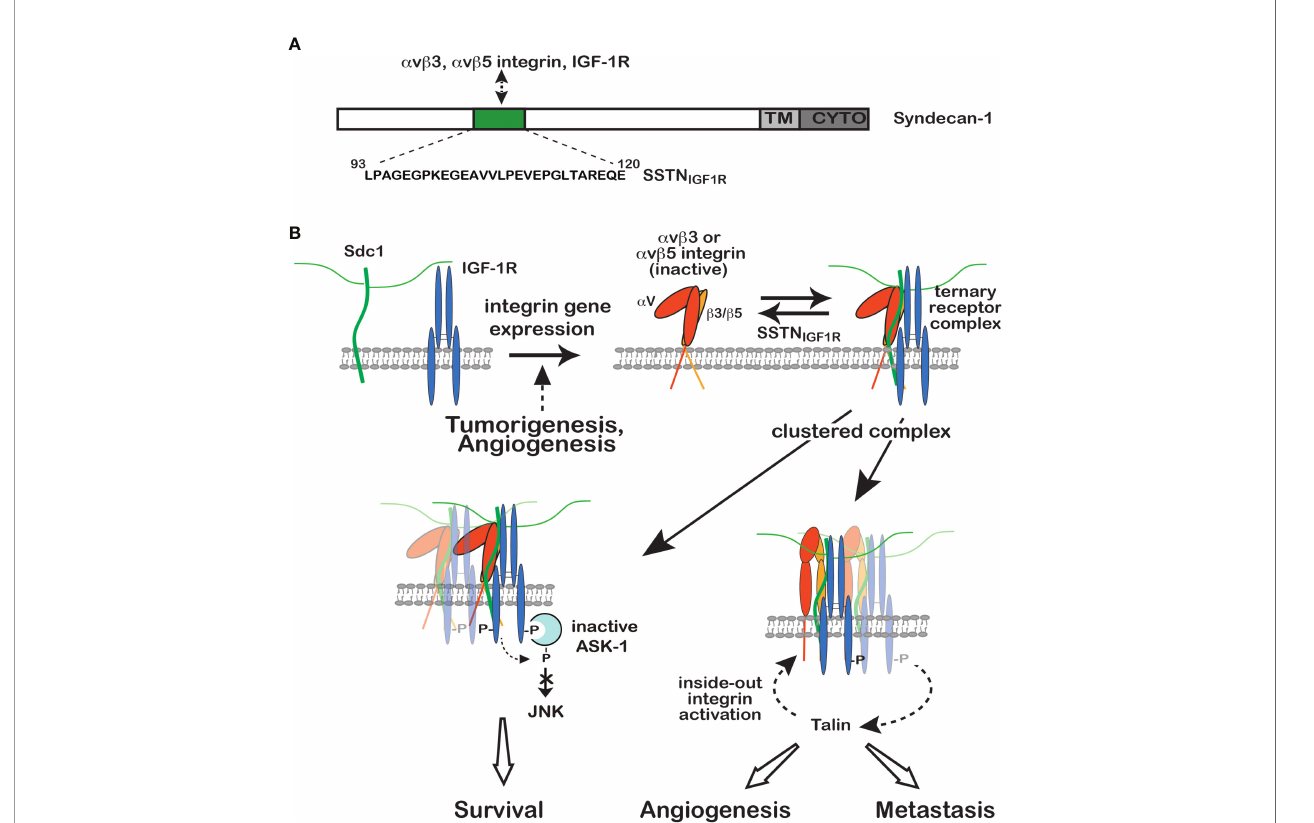
FIGURE 1 | Regulation of IGF-1R signaling by Sdc1. (A) Model depicting site of IGF-1R capture, along with either the a v b 3 or a v b 5 integrin, in the extracellular domain of human Sdc1. A peptide mimetic of this site, SSTN IGF1R , competitively blocks receptor binding. (B) IGF-1R is not engaged with Sdc1 in nontransformed cells, typically because they lack the a v b 3 and a v b 5 integrins (top left). But integrin expression, usually in response to malignant transformation or activation of endothelial cells during angiogenesis, results in integrin docking to the extracellular domain of Sdc1, which is followed by IGF-1R capture at the same docking site (top right). Once formed, constitutive or matrix-induced clustering of the ternary receptor complex activates IGF-1R by autophosphorylation that does not require IGF-1. Activated endothelial cells or tumor cells bearing the ternary receptor complex rely on the syndecan-activated IGF-1R to phosphorylate and suppress the activity of Apoptosis-Signal regulating Kinase-1 (ASK-1) engaged with the IGF-1R cytoplasmic domain (bottom left), preventing ASK-1-mediated activation of Jun-N- terminal Kinase (JNK) and blocking entry into apoptosis, thus promoting tumor cell survival. In a second activity (bottom right), downstream signaling from IGF-1R activates the a v b 3 or a v b 5 integrin via an inside-out signaling pathway that targets the integrin-activating protein Talin, resulting in endothelial or tumor cell motility during the onset of angiogenesis or tumor cell invasion. SSTN IGF1R competitively disrupts the ternary receptor complex, preventing integrin activation and removing the constitutive suppression of ASK-1. Neither activity can be rescued by IGF-1 when the receptor complex is disrupted by SSTN IGF1R , emphasizing the singular role played by the syndecan in this IGF-1R signaling mechanism (see discussion in text, references (27, 39 – 41) and references